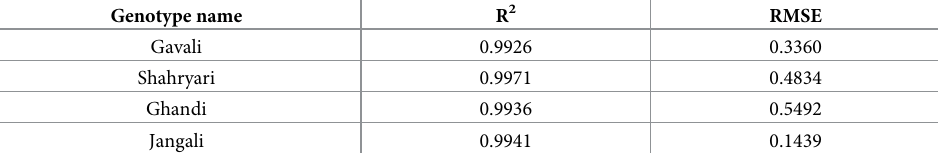
Table 13. Evaluation results of the 2019 data-based trained SVR model on the data collected in 2021 from three greengage plum genotypes and one myrobalan